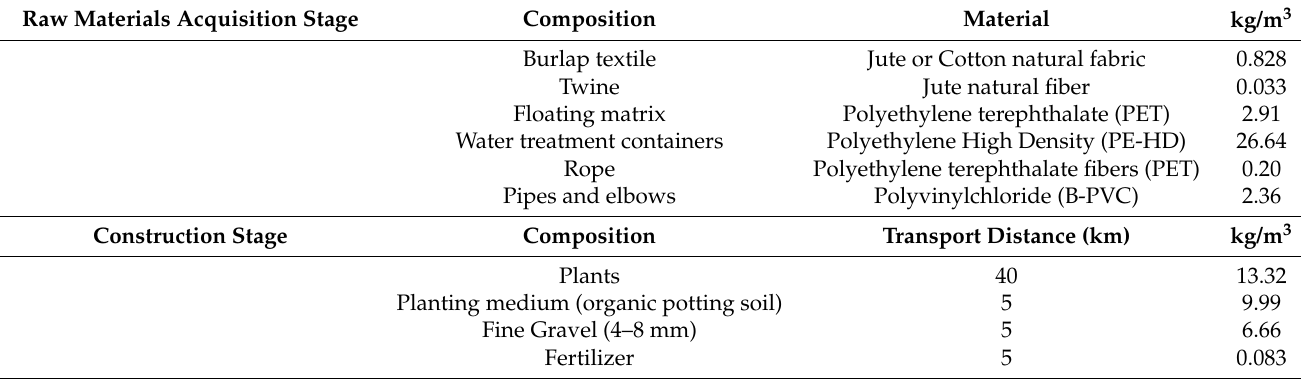
Table 1. Life cycle inventory data during raw materials acquisition stage and construction stage.